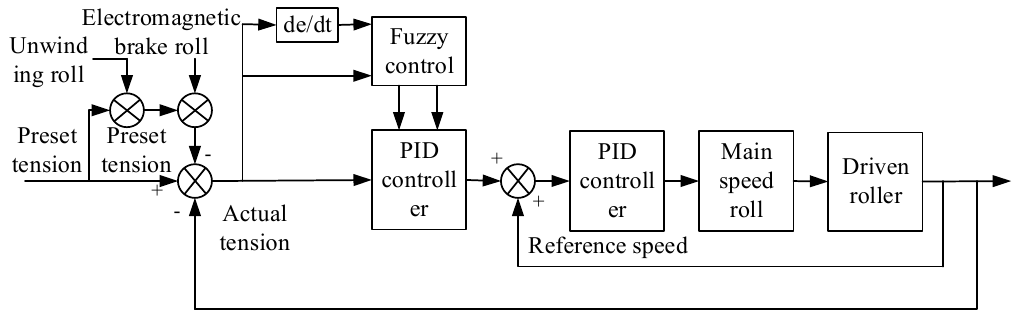
Figure 7. Tension control based on fuzzy PID.